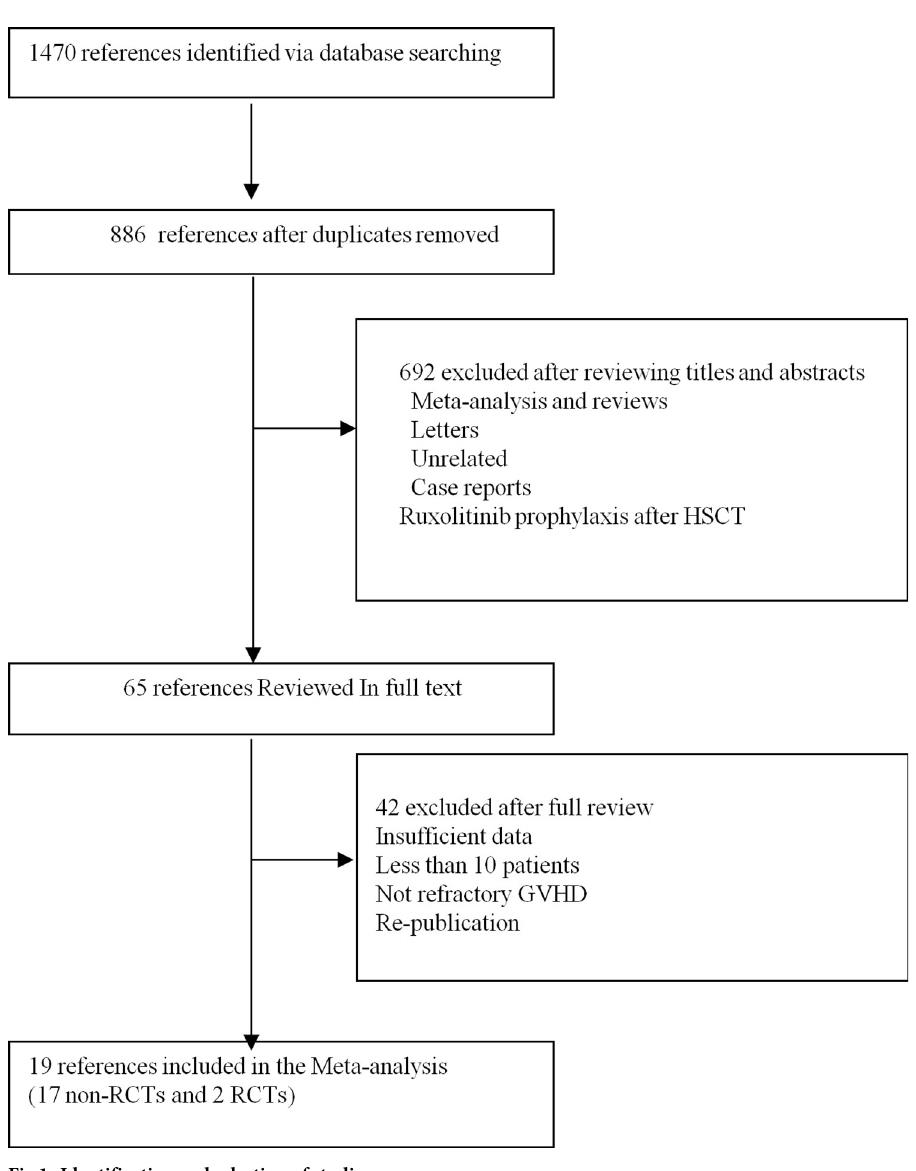
Fig 1. Identification and selection of